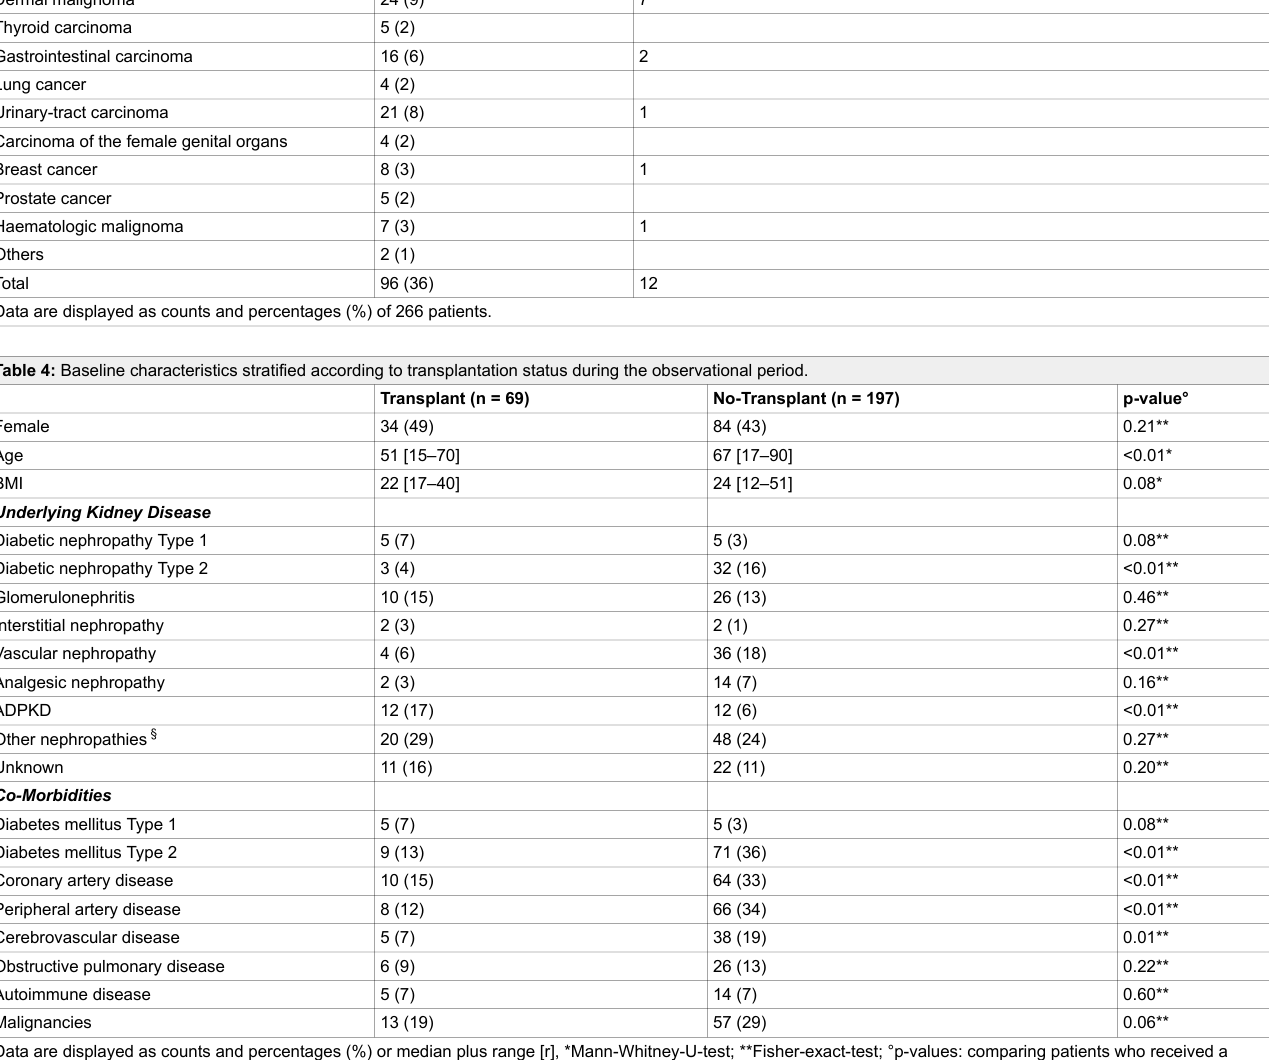
Table 3: Frequency of malignancies in 266 patients undergoing chronic haemodialysis. Type of malignancies